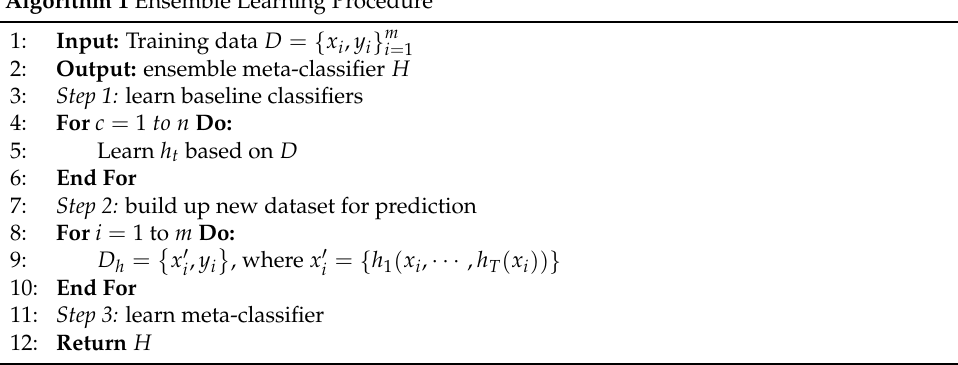
Algorithm 1 Ensemble Learning